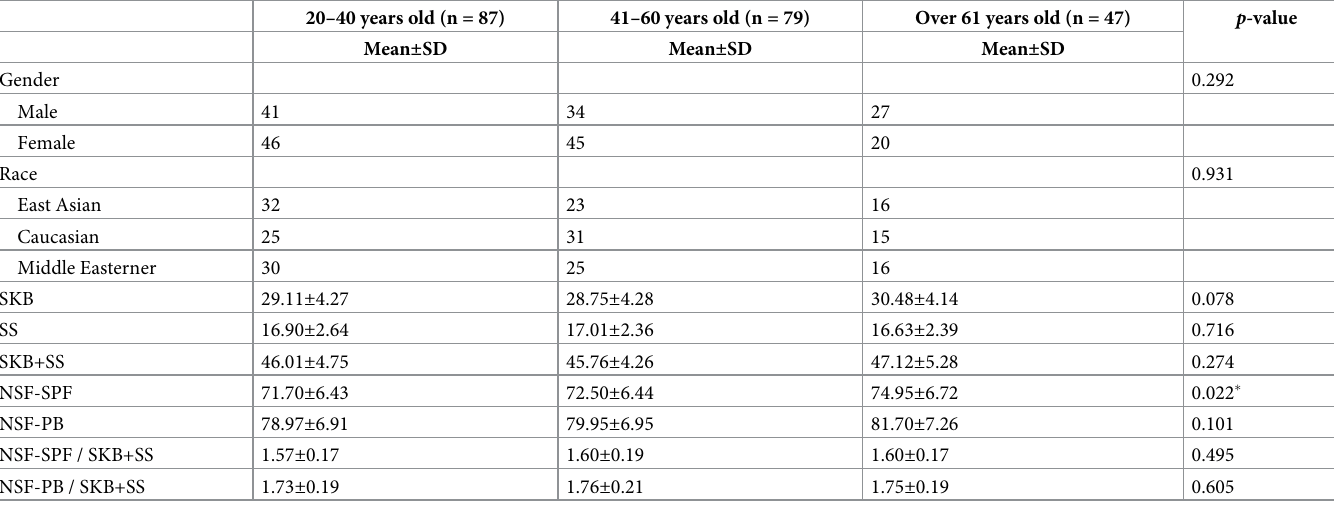
Table 3. Summary of patient characteristics and CT measurements by age.